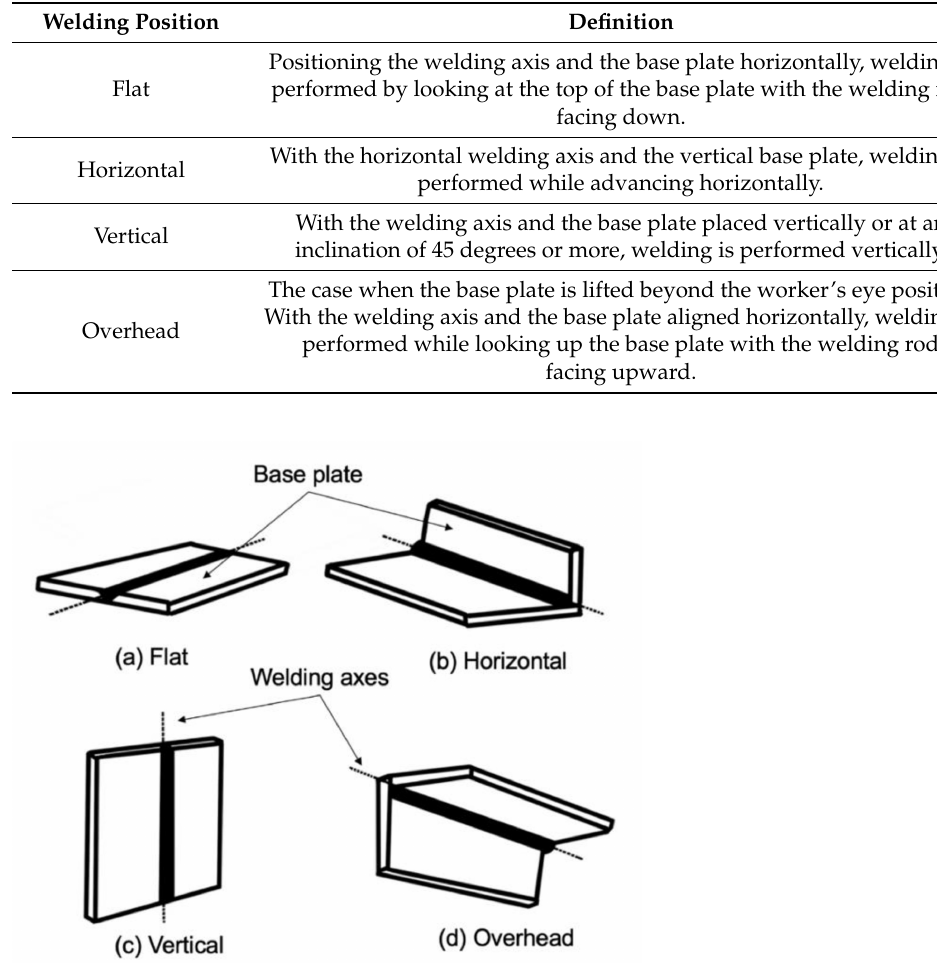
Table 1. Definition of four industrial standard welding positions.